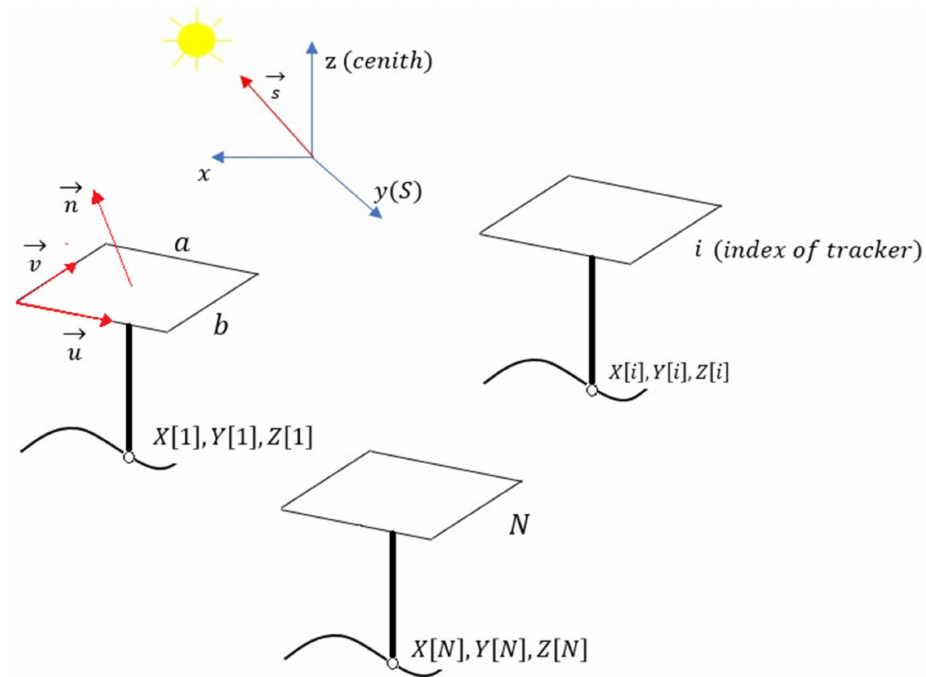
Figure 1. Geometric elements necessary to determine the existence of inter-shading according to the algorithm of Fernandez-Ahumada et al.